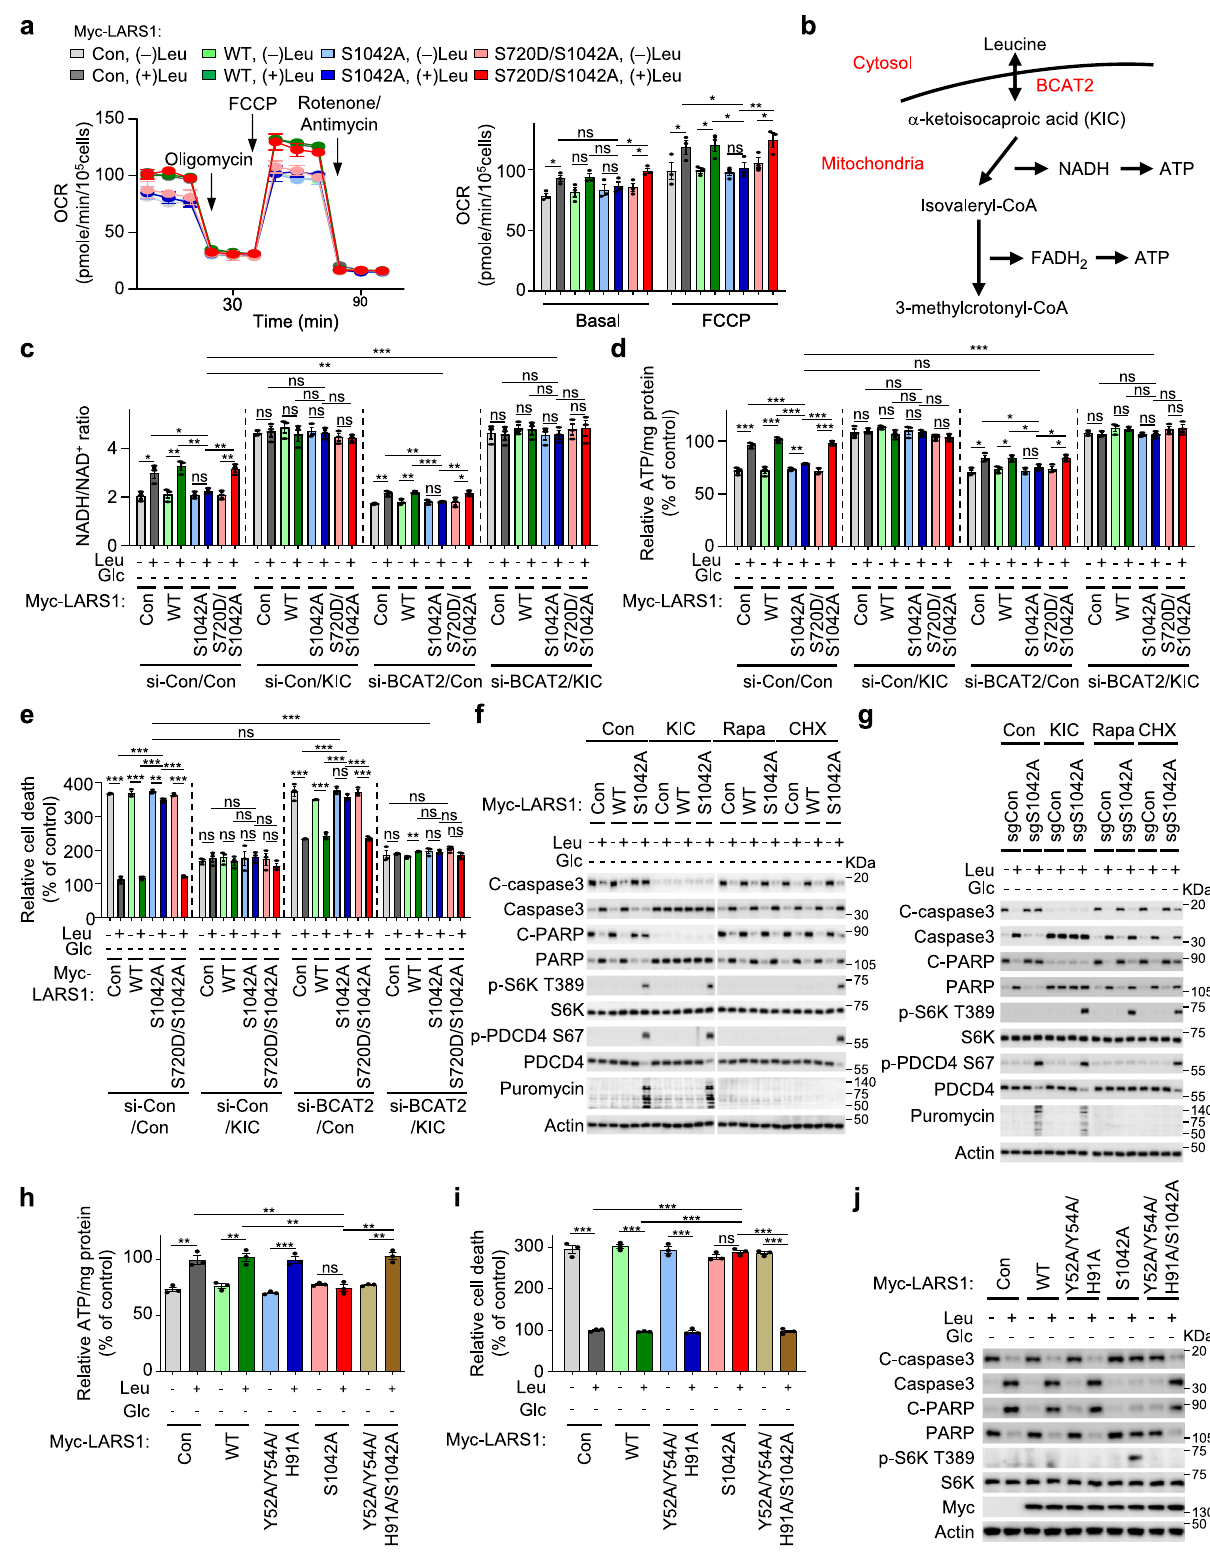
Fig. 7e) or the absence of